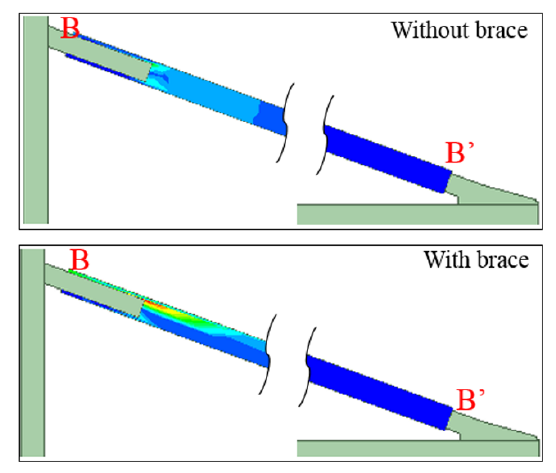
Figure 14. Localized E-Field near to end-fittings of the alternate tie member (B –B’ ).